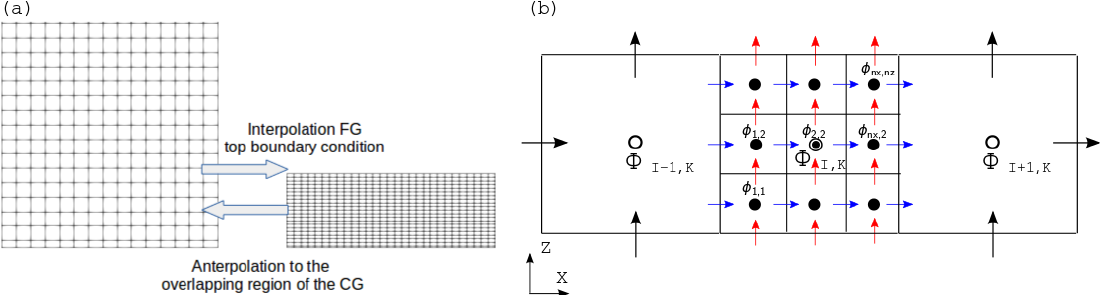
Figure 1. (a) Schematic of the interpolation and anterpolation between grids. The FG top boundary condition is interpolated from the CG. The CG prognostic quantities in the overlapping region are anterpolated from the FG. (b) Schematic of Arakawa C grid for two grids with nesting ratio of 3. The black arrows and circles are CG velocity and pressure, respectively. The blue and red arrows are horizontal and vertical velocity, respectively, in the FG. The filled black circle is the FG pressure. The symbols (cid:56) and φ represent CG and FG scalar quantities. I and K are CG indices and nx and nz are the nesting ratio in x and z ,